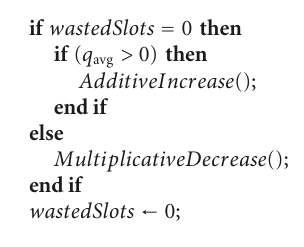
Algorithm 1: UBS weight